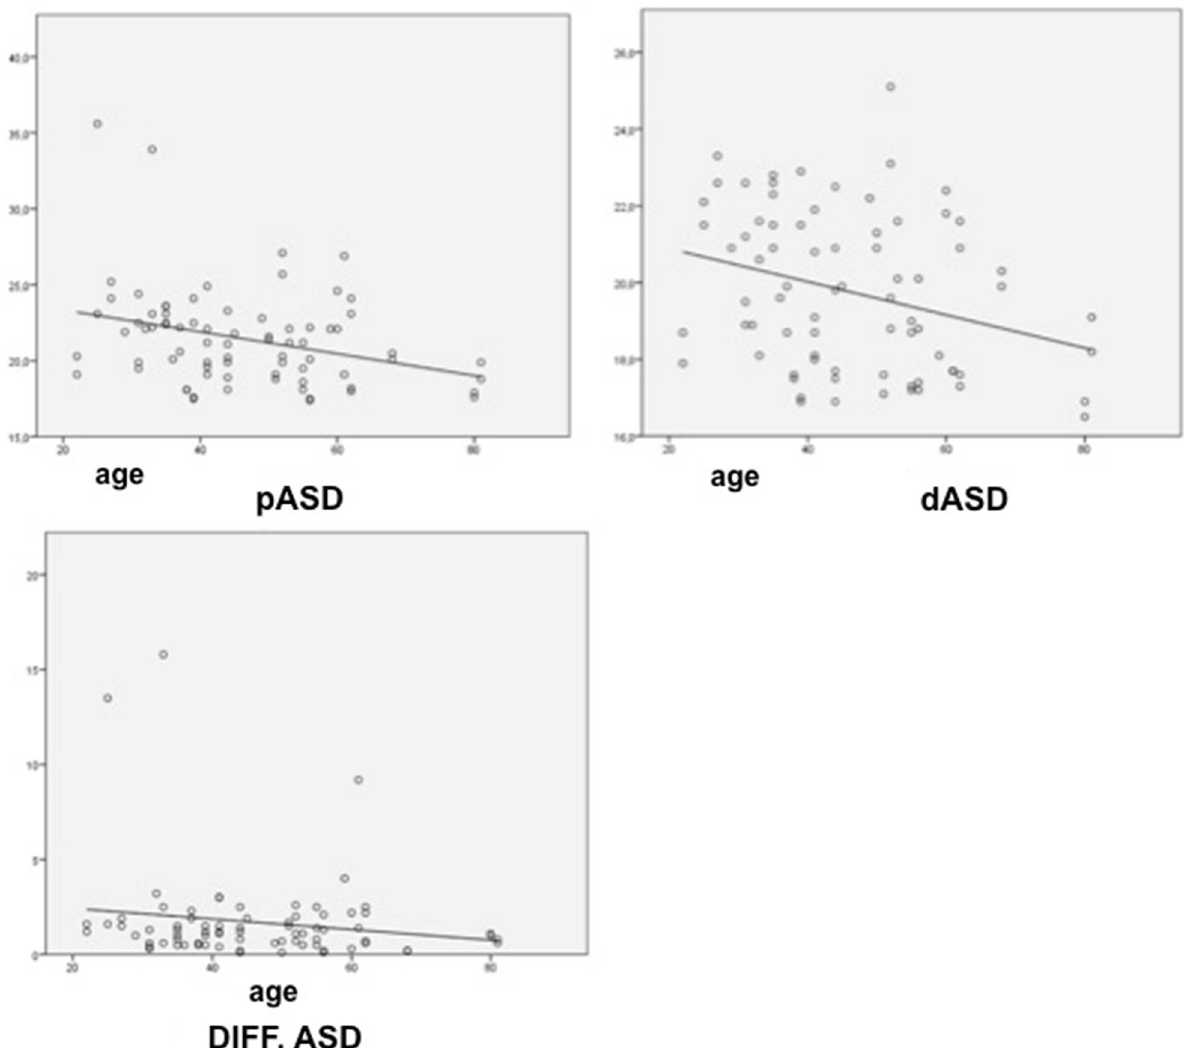
Fig. 3 Correlation between antero‑superior elbow diameter (longitudinal evaluation) and age. Top left: proximal location. Top right: distal location. Bottom: difference between diameters